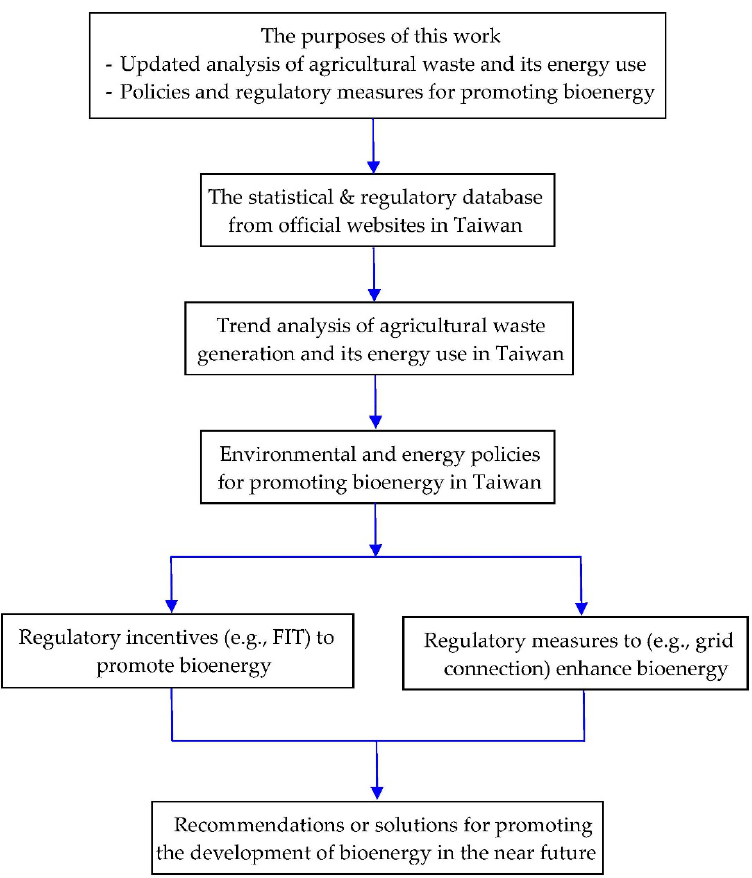
Figure 1. A conceptual flowchart for the major steps of this work.